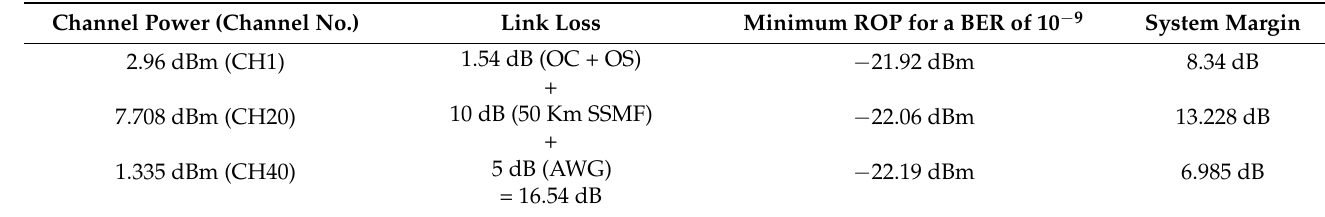
Table 5. System margins of the protection scheme for ROA 1 .